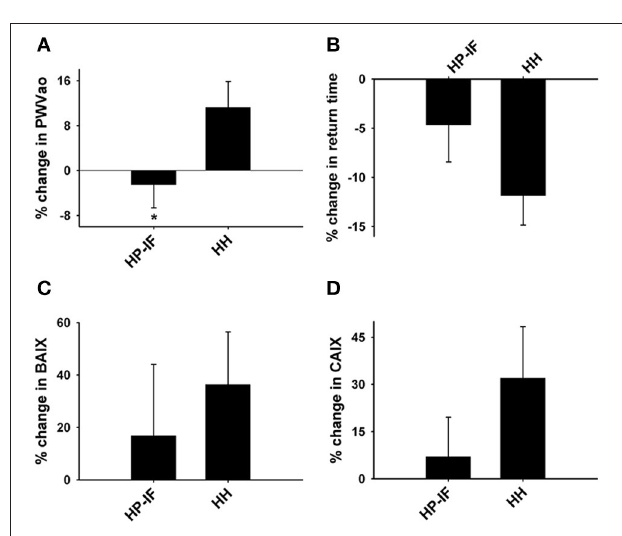
FIGURE 6 | Percent changes in (A) PWVao, (B) return time (the time intervals between peaks from the early direct and reflected late systolic waves), (C) BAIX, and (D) CAIX between the HP-IF and HH groups following Phase 2 (52 weeks). *Significant difference from the HH group ( p = 0.045), as assessed by repeated-measures ANOVA. PWVao, aortic pulse wave velocity; HP-IF, high-protein, intermittent fasting; HH, heart healthy; BAIX, brachial augmentation index; CAIX, central augmentation